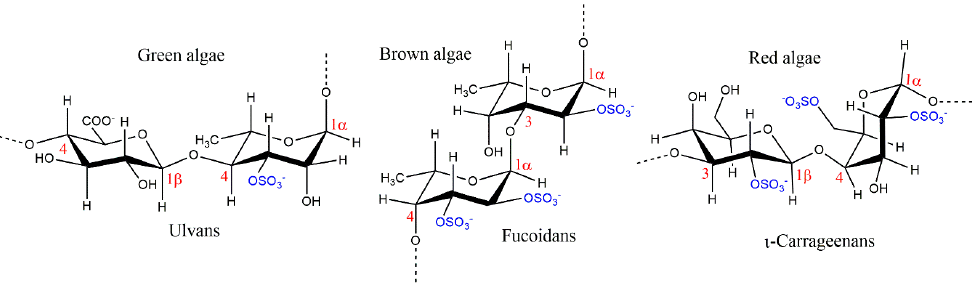
Figure 2. Characteristic backbones of macroalgae sulfated polysaccharides.